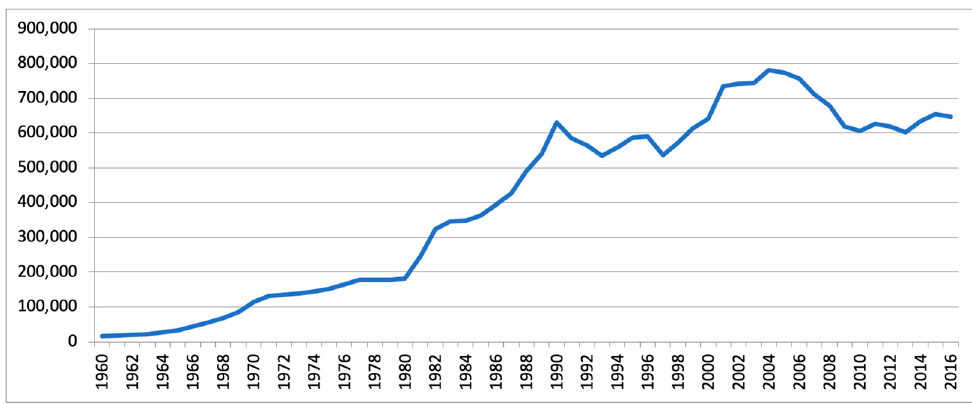
Figure 1. Number of Sierra Club members,